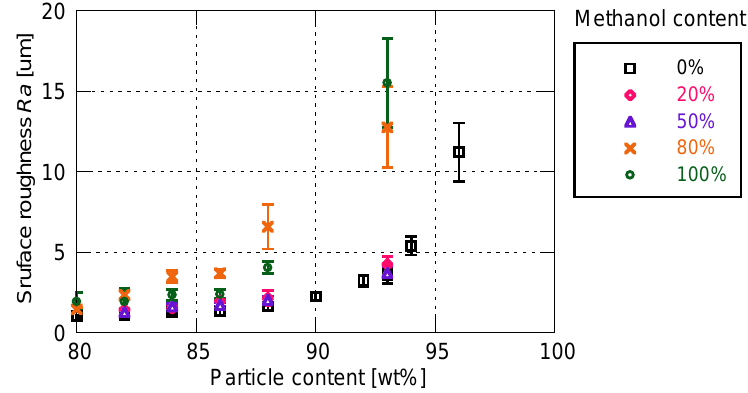
Figure 9. Surface roughness related to methanol content for particle/dye solution.